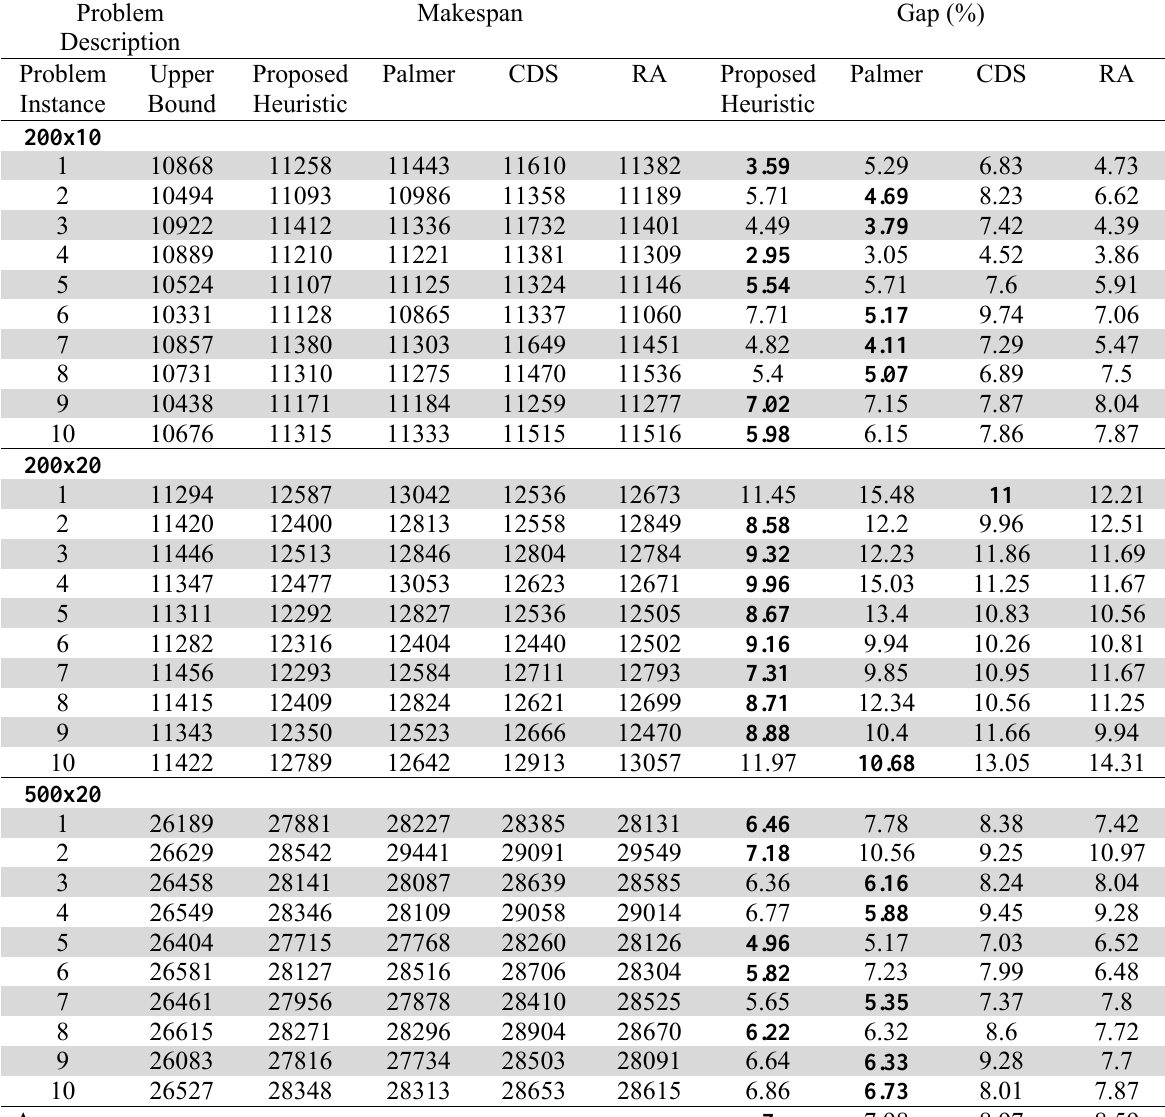
Makespans and percentage gaps for Taillard’s 200-Job and 500-job benchmark